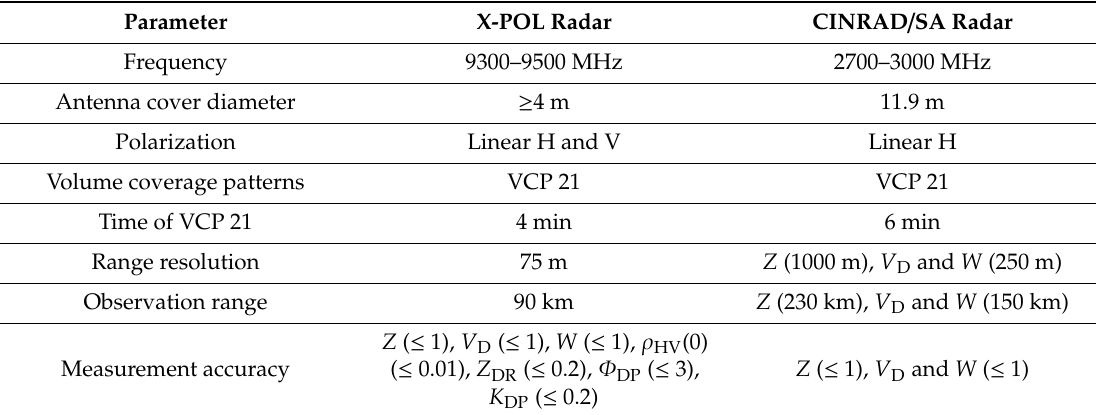
Table 1. System characteristics of CINRAD / SA radar and X-POL